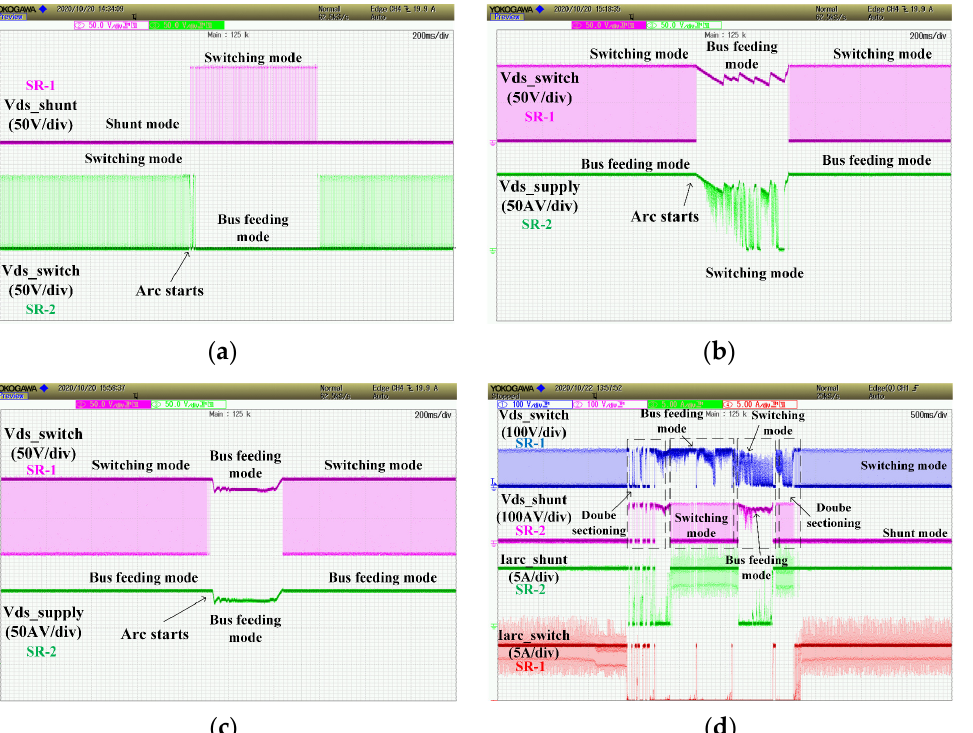
Figure 26. Influence of arc on SR operation mode. ( a ) Switch between two operation modes when stable arc occurs in SR ‐ 2 (switching mode); ( b ) Switch between two operation modes when intermittent arc occurs in SR ‐ 2 (bus feeding mode); ( c ) Switch between two operation modes when stable arc occurs in SR ‐ 2 (bus feeding mode); ( d ) Switch among three operation modes when arc occur at random in two SRs.